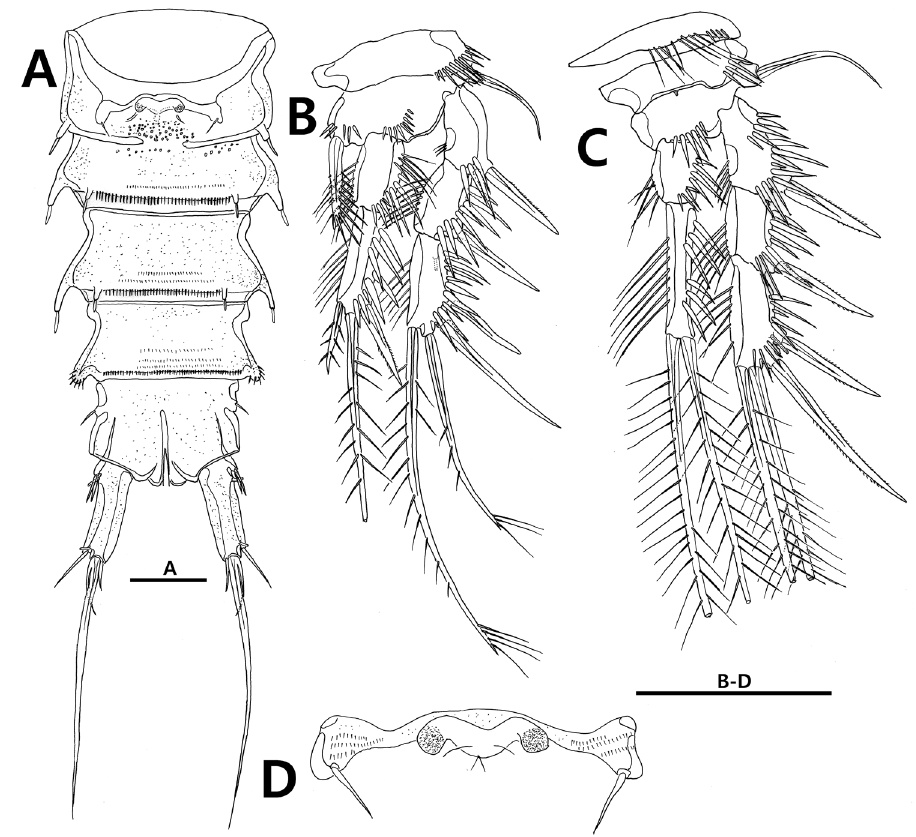
Figure 4. Strongylacron glabrum sp. n. female. A urosome except P5-bearing somite, ventral B genital field C P1 D P2. Scale bars 50